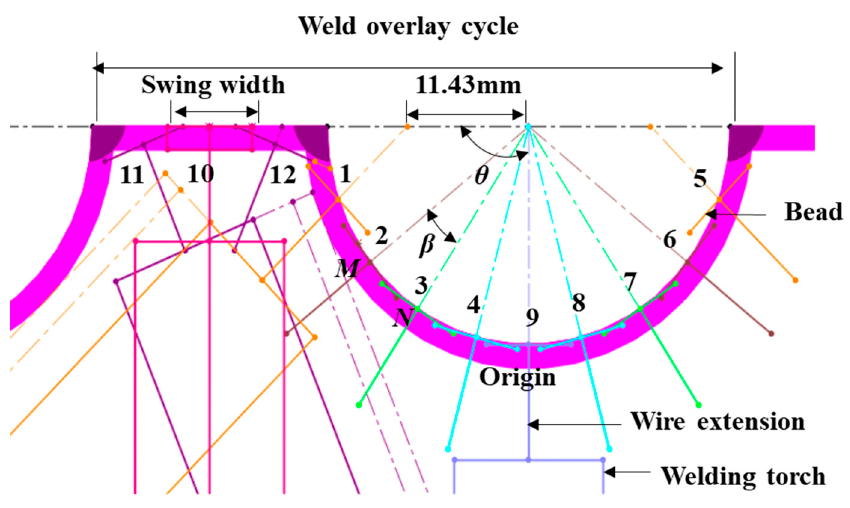
Figure 3. Schematic of weld beads sequence.